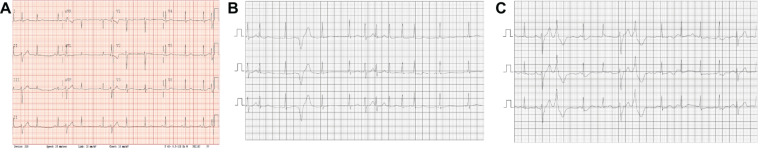
ECGs/Relevant Clinical Data. (A) Standard 12-lead ECG obtained from the patient with the novel SCN5A mutation. Sinus rhythm with frequent polymorphic premature wide complex beats, low T-wave amplitude and inverted T-waves in the right precordial leads (V1 and V2), normal axis and QRS duration and QTc = 396. (B,C) Segments from 24 h Holter monitoring. (B) Shows a non-sustained irregular narrow complex tachycardia suspected to be atrial tachycardia. (C) Shows bi-directional PVCs.